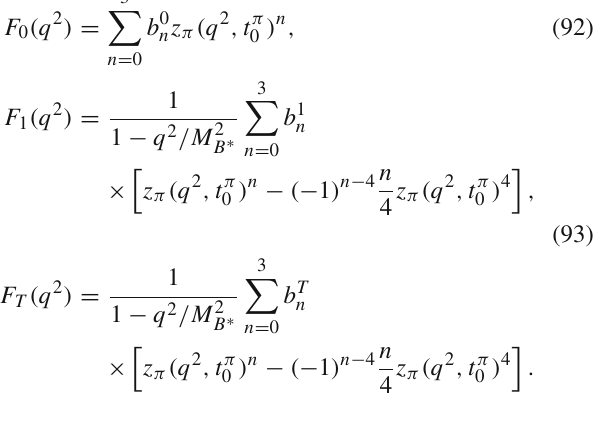
Table 15 Mass terms for the form factor evaluation in Eq. (85) [33] Form factor F i m R , i / GeV